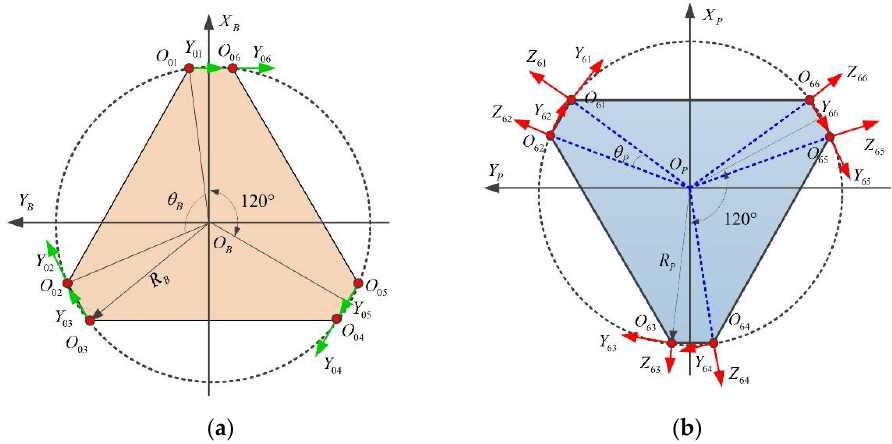
Figure 8. Layouts of local coordinate systems: ( a ) At the base platform; ( b ) At the mobile platform. Table 1. Parallel platform configuration parameters.